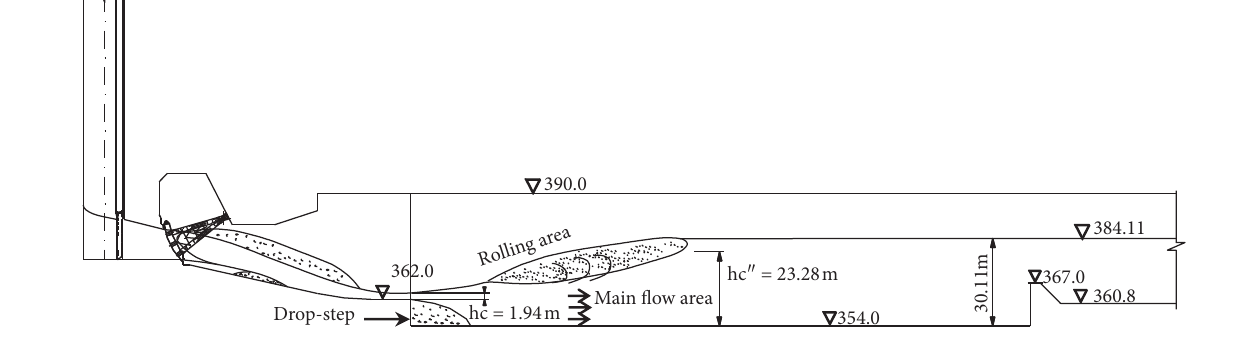
Figure 15: Diagram of hydraulic jump (unit: m).